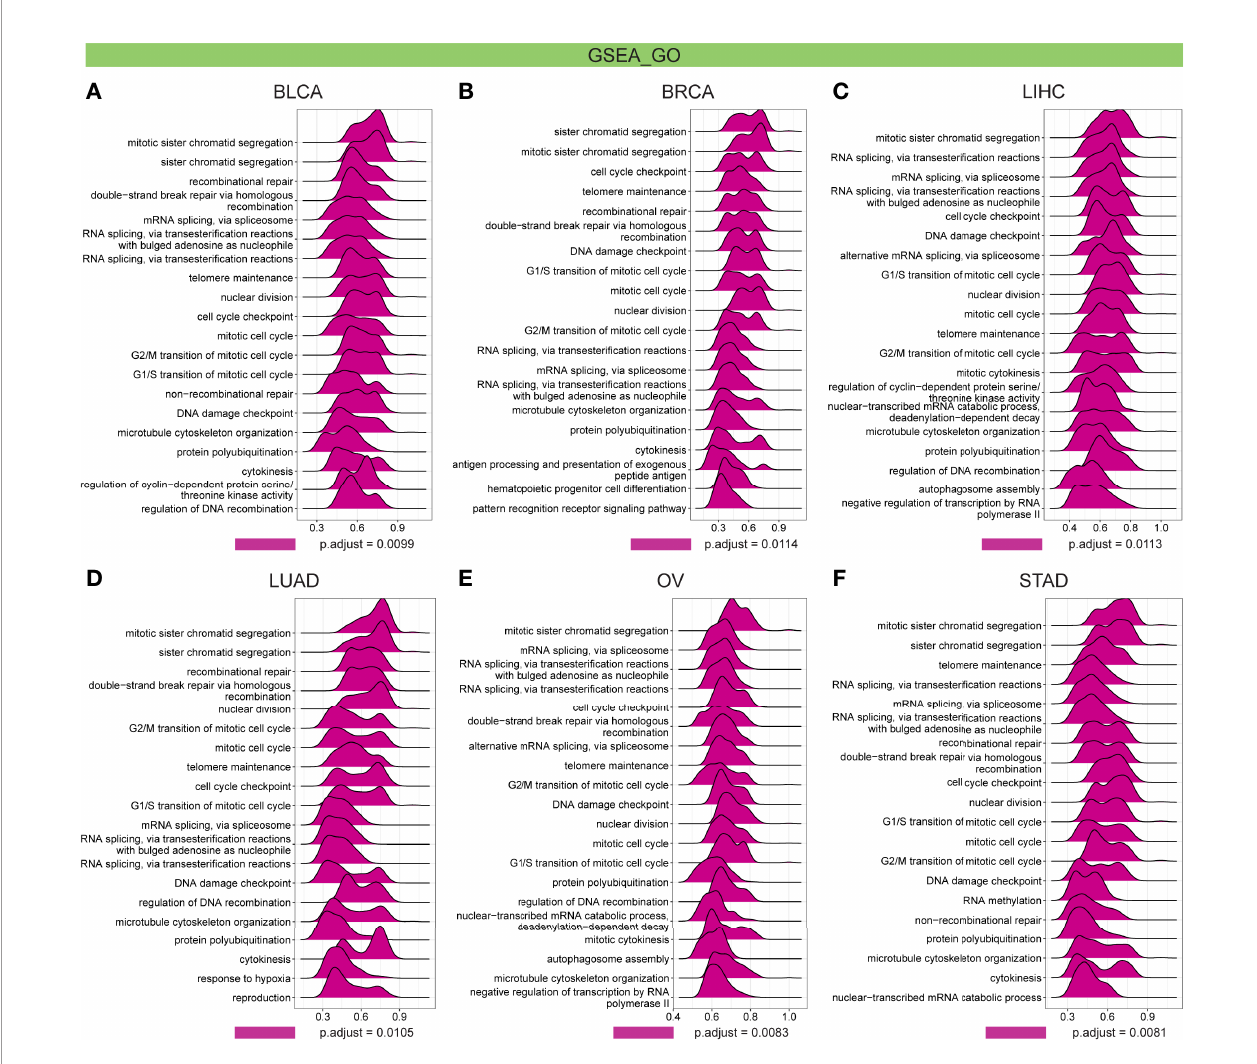
FIGURE 9 | GO annotations of FBXO5 in the indicated six types of tumors using GSEA, including (A) BLCA, (B) BRCA, (C) LIHC, (D) LUAD, (E) OV, and (F)